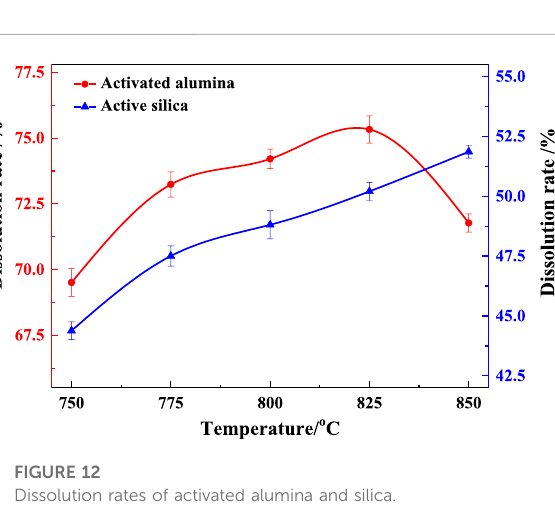
FIGURE 12 Dissolution rates of activated alumina and silica.